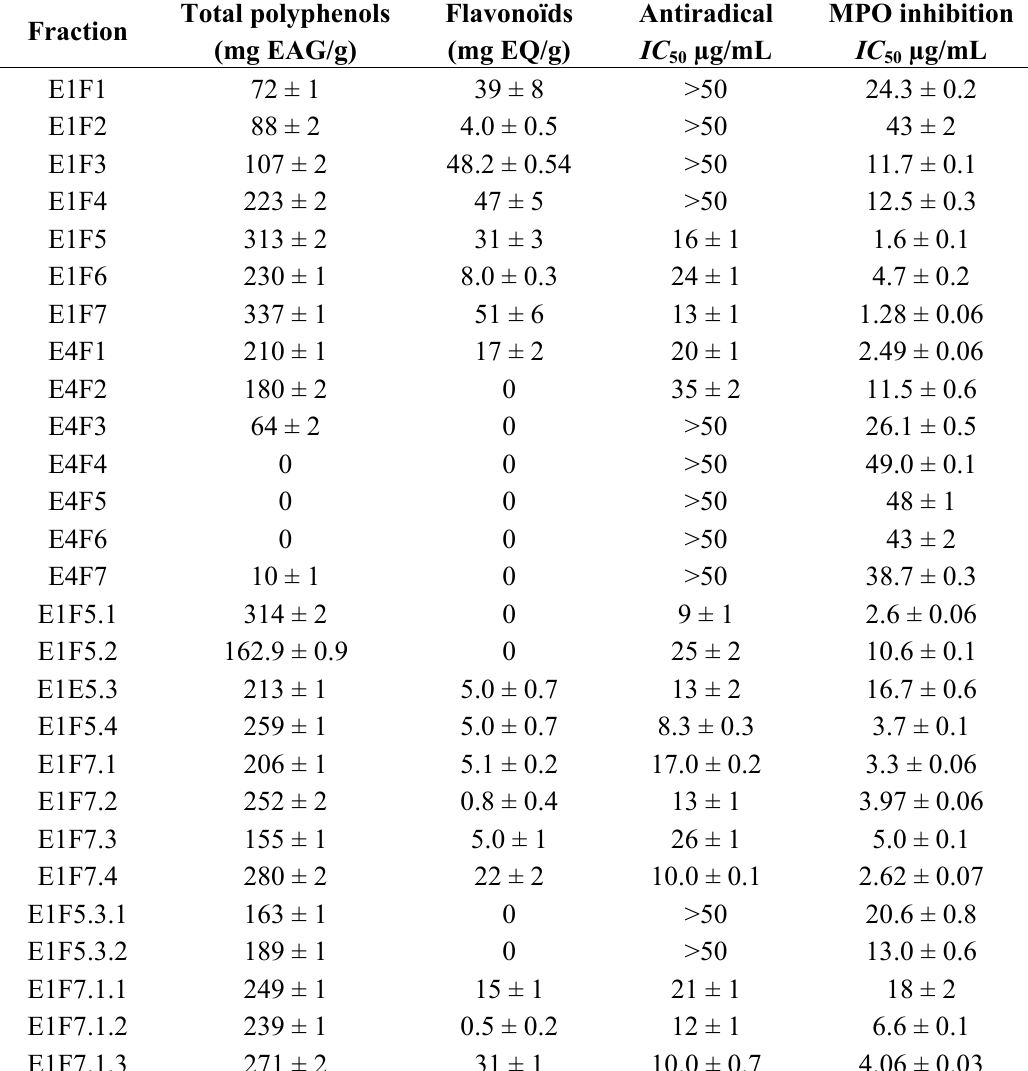
Table 3. Concentrations of flavonoids and polyphenols, antiradical scavenging activity and MPO inhibition activity of propolis fractions obtained from propolis type 1 and